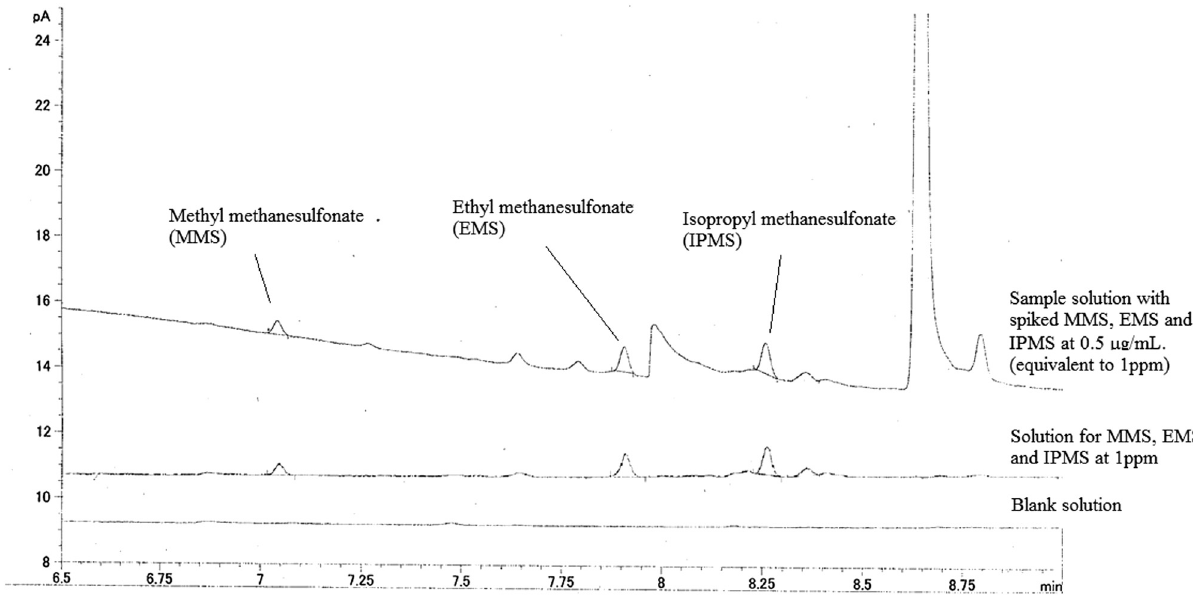
Figure 2: GC chromatograms for MMS, EMS, and IPMS spiked sample solutions and standard solution equivalent to 1 ppm in the delgocitinib drug 0.5 µg/mL of MMS, EMS, and IPMS ( which corresponds to 1 ppm in the delgocitinib drug substance ) are shown in